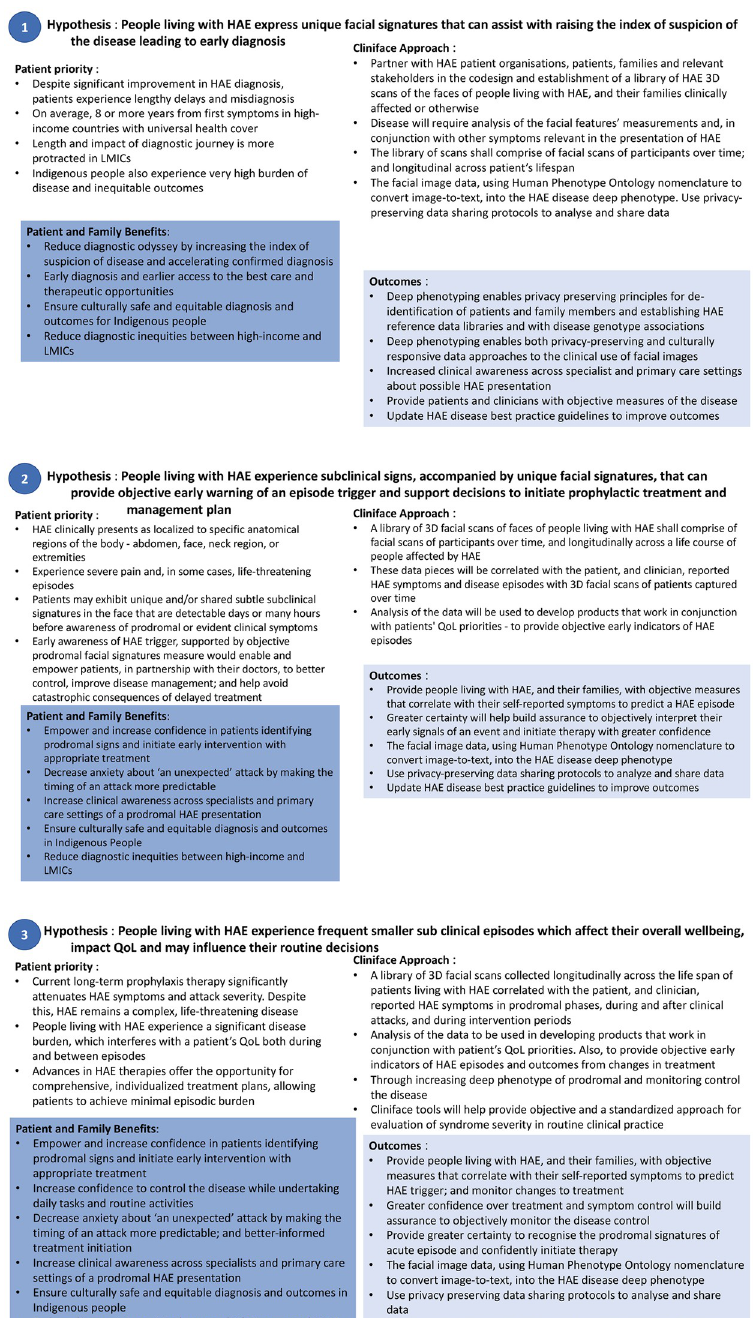
Fig 4. (1) Increasing index of suspicion and improving early detection and diagnosis of HAE. (2) Early objective prodromal indicators of an imminent HAE episode. (3) Improve treatment outcomes and QoL for patients living with